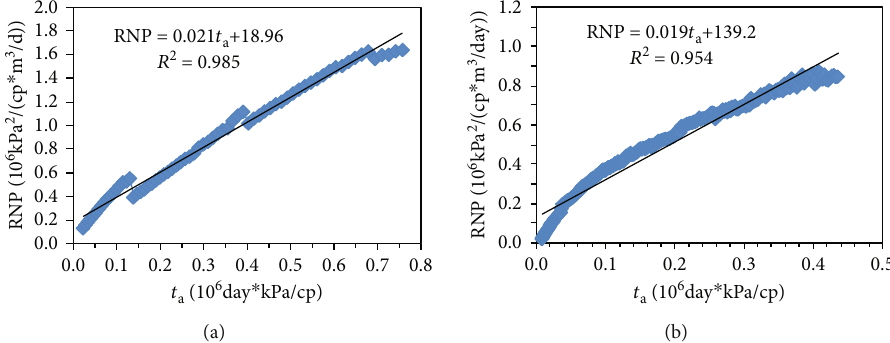
Figure 10: Analysis of EGP data of two wells belonging to southern Sichuan: rate-normalized pressure change with pseudotime. (a) Well 3 and (b) Well